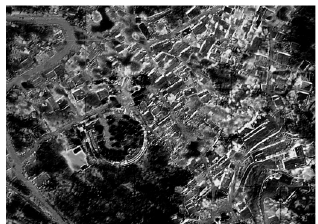
Figure 5. The probability map of uncollapsed building